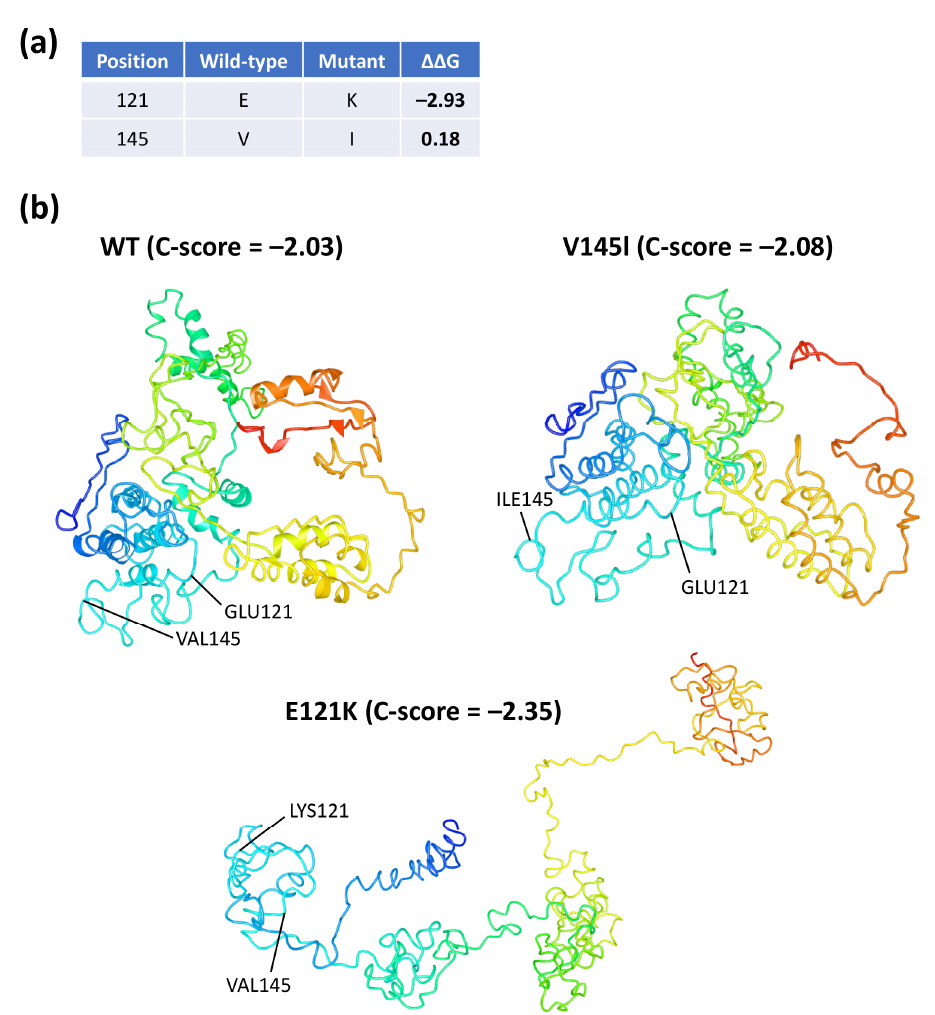
Figure 6. Coilin in silico structural prediction and analysis. ( a ) Protein stability was predicted by STRUM (https: // zhanglab.ccmb.med.umich.edu / STRUM). A positive ∆∆ G value indicates the mutation induces protein stability whereas a negative value causes destabilization [29]. ( b ) Protein models with the highest C-scores predicted by I-TASSER server (https: // zhanglab.ccmb.med.umich.edu / ITASSER) using the amino acid sequences of the coilin WT and SNP variants [28]. The displayed proteins were modified and generated using NCBI’s iCn3D.